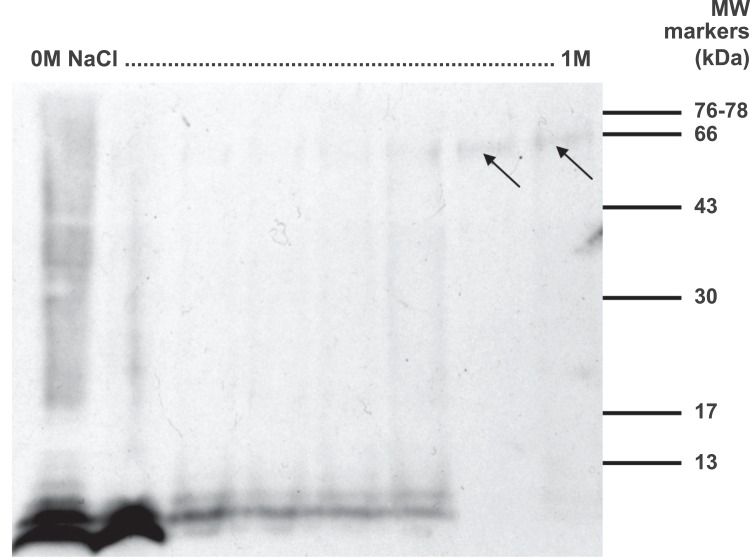
Western blot of anionic exchange chromatography fractions of rat hypothalamus extract.Salt gradient indicated, 0–1 M NaCl. About 10 μl from every fifth fraction (from 50) was run on a 15% SDS PAGE gel in non-reducing conditions and analysed by western blot using the anti-EPL001 goat polyclonal antibody at a dilution of 1/400. Arrows denote broad faint bands of 60–65 kDa in high salt fractions.